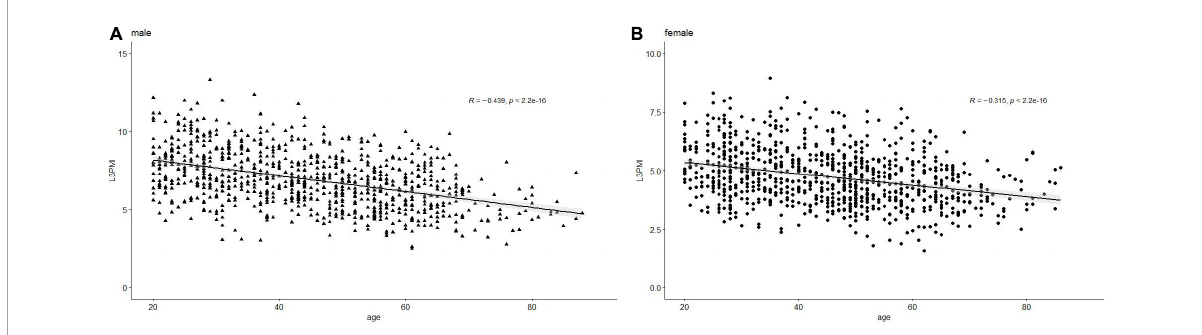
FIGURE2 Scatter graph of the L3-PMI classified according to age decades in (A) male and (B) female. Data are analyzed using the Pearson correlation coefficient.